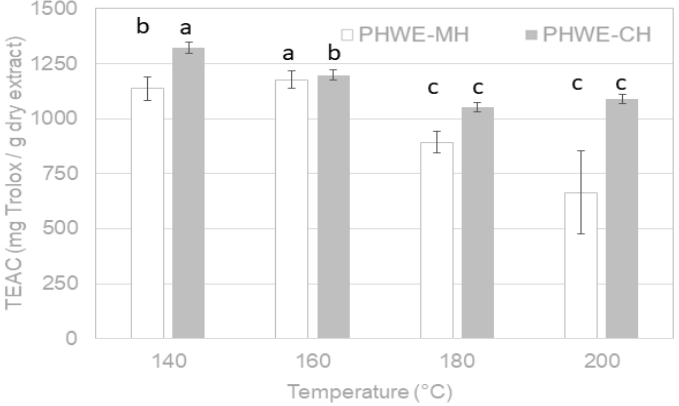
Figure 4. Antioxidant capacity of extracts influenced by temperature during PHWE-MH and PHWE-CH of A. chilensis leaves expressed as mg Trolox/g dry extract. Letters above the graph bars (i.e., a,b,c) indicate significantly different values (95% confidence, p < 0.05).